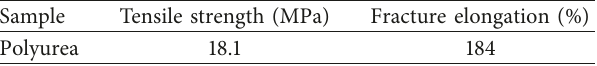
Table 2: Physical and mechanical properties of polyurea used in blast tests.